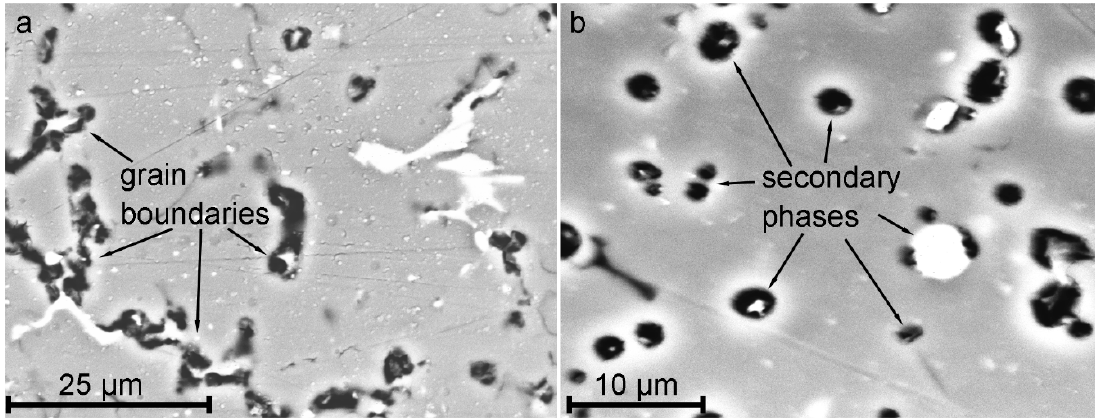
Figure 9. SEM images of HAZ corrosion degradation realized at the grain boundary ( a ) and around cathodic phases ( b ).